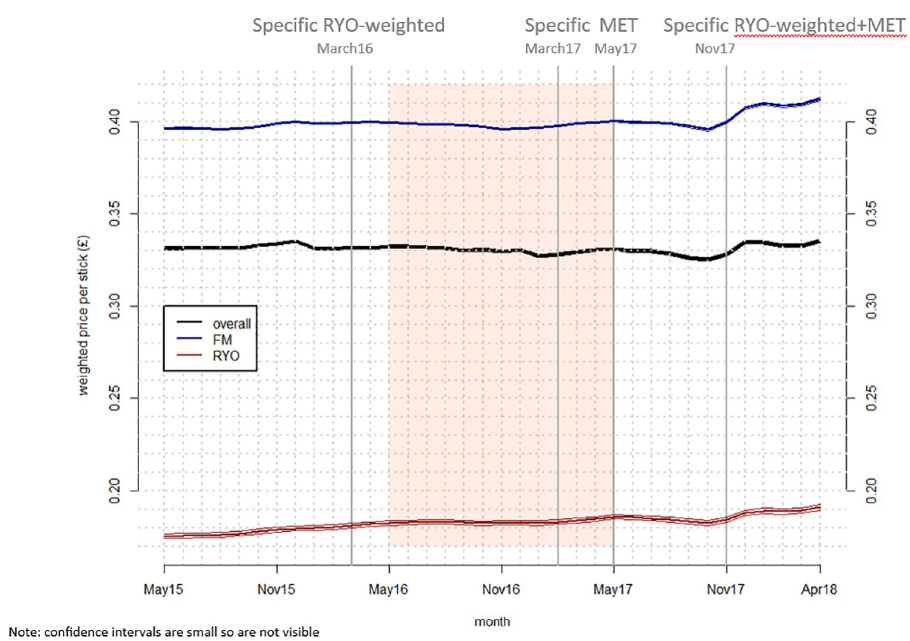
Fig 1. Mean and 95% confidence intervals (CI) of weighted real price per stick overall and by product type (vertical lines denote tax changes and the shaded area is the implementation